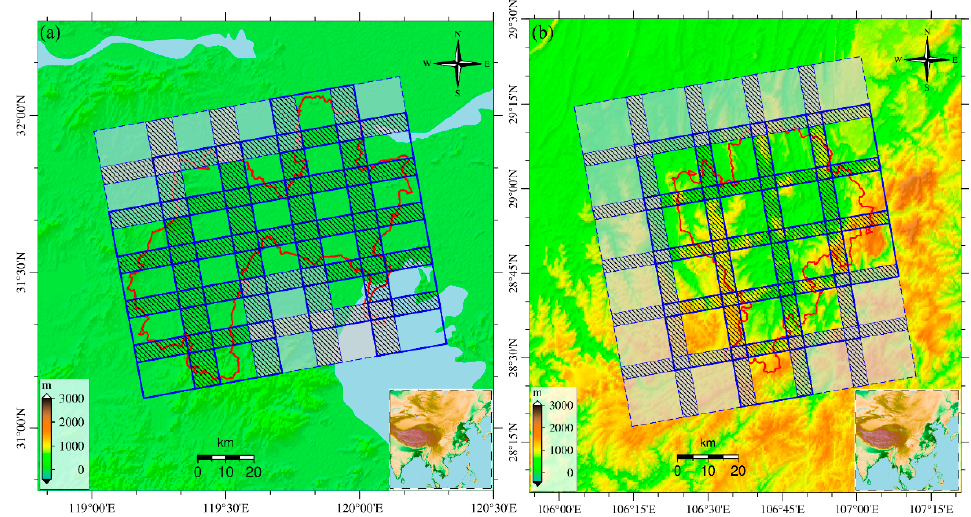
Figure 4. Data coverage for ( a ) Changzhou City and ( b ) Qijiang City. The red line is the administrative division boundary. The blue frame is the image coverage after partition and the shaded part is the overlapping area. The gray blocks are not in the study area.